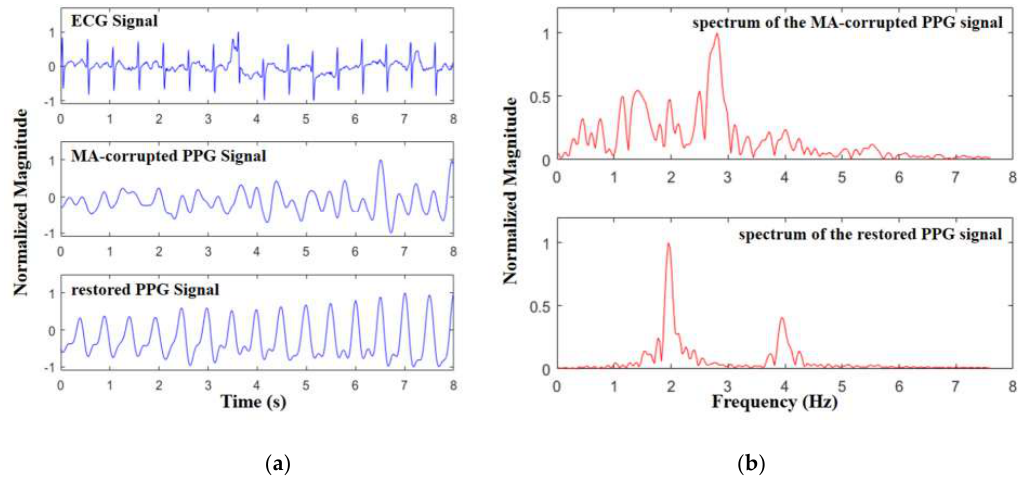
Figure 6. The performance of the proposed method to restore photoplethysmography (PPG) signal: ( a ) comparison of PPG signals before and after the proposed algorithm in time domain, with electrocardiograph (ECG) signal as reference; ( b ) comparison of PPG signals before and after the proposed algorithm in frequency domain.